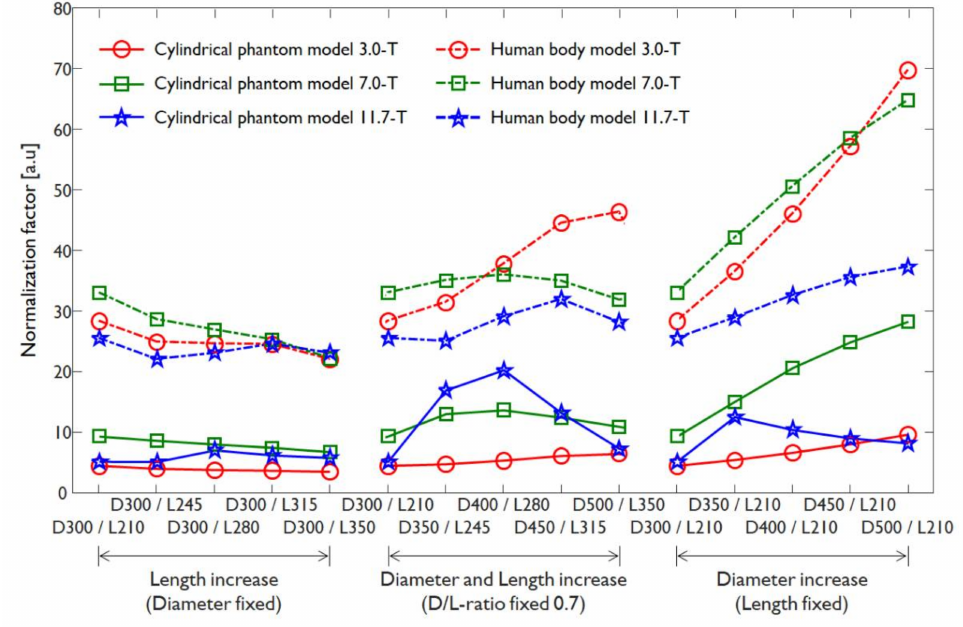
Figure 4. Normalization factors applied for the normalized |B 1+ |-field calculation when using a cylindrical phantom model or a human body model at 3.0, 7.0, and 11.7 T MRI